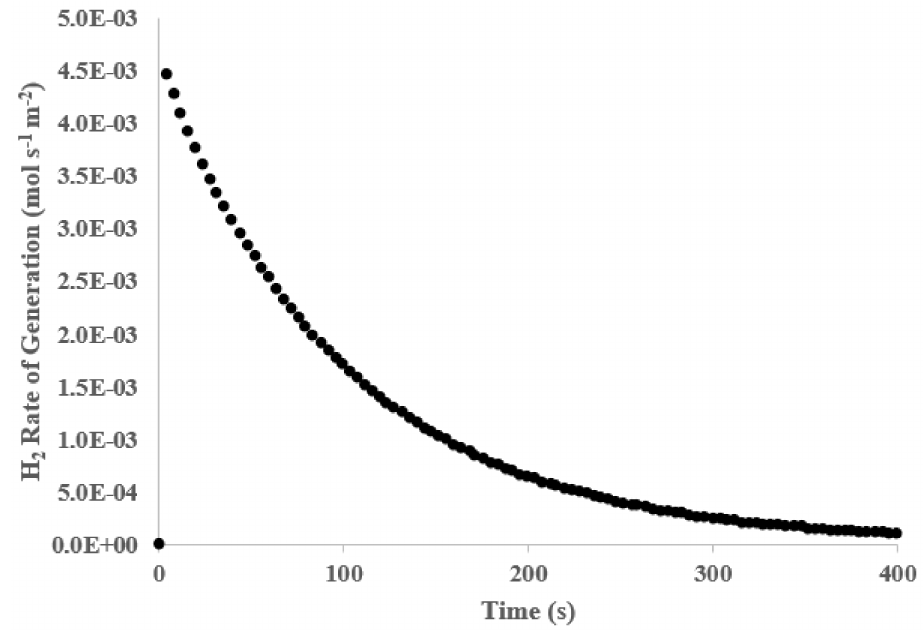
Figure 8. Rate of hydrogen gas production per unit electrode area in the